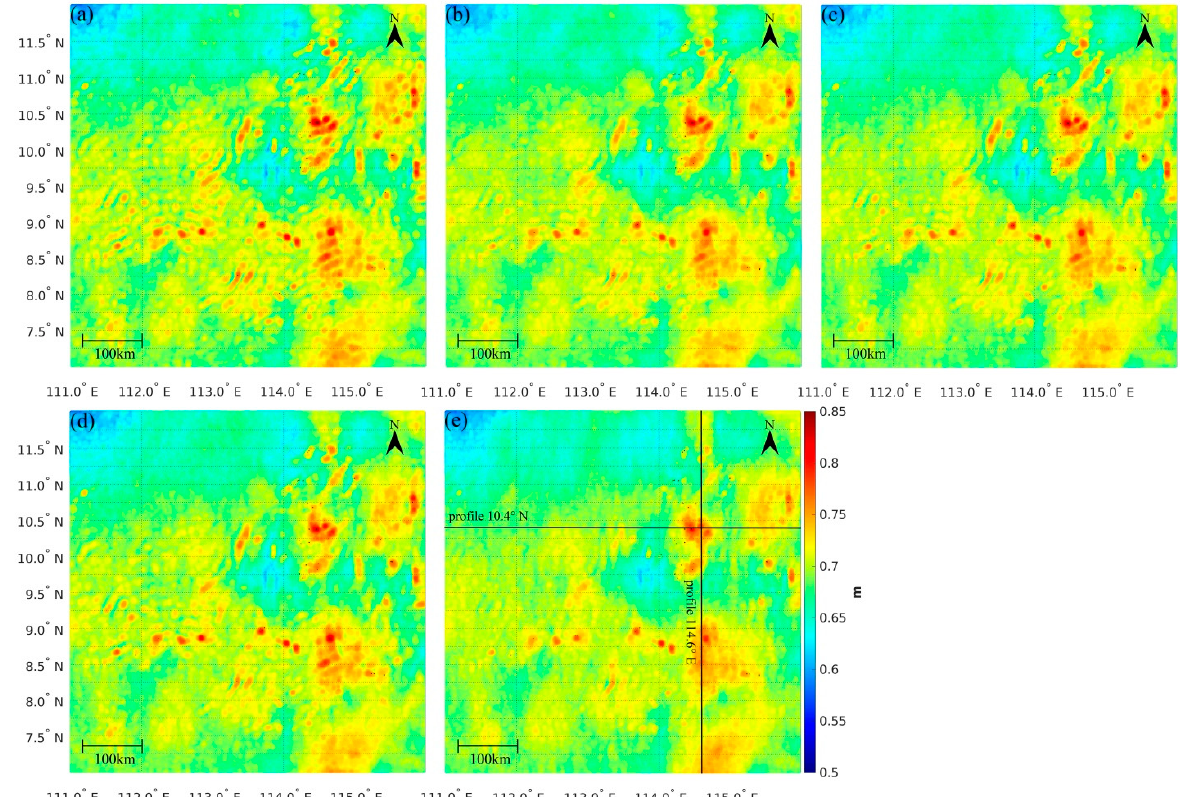
Figure 3. MDT modeled with the quasi-geoid computed from ( a ) XGM2019e_2159, ( b ) DTU13GRA, ( c ) DTU15GRA, ( d ) DTU17GRA, and ( e ) DTU21GRA. The geographical coordinates are expressed in the Plate Carrée projection. Note: only DTU21GRA was computed with the SAR altimetry data derived from Sentinel-3A/B over the study area.